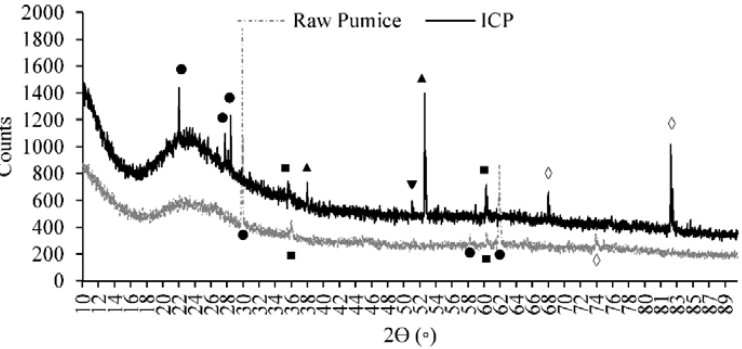
Figure 2. XRD patterns for raw and iron ‐ coated pumice samples (•: (Ca, Na)(Si, Al) 4 O 8 , ▼ : Na(Si 3 Al)O 8 , ▲ : α‐ Fe 2 O 3 , ■ : α‐ FeOOH, ◊ : Fe).